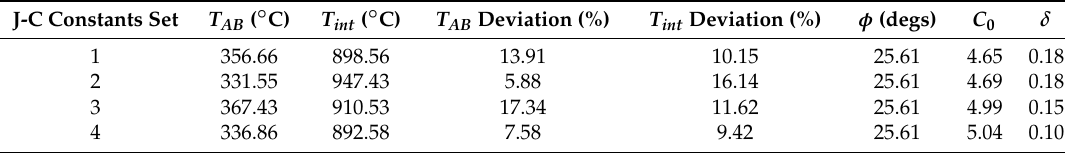
Table A3. Predicted temperatures and other variables with multiple sets of J-C constants under test 1 cutting